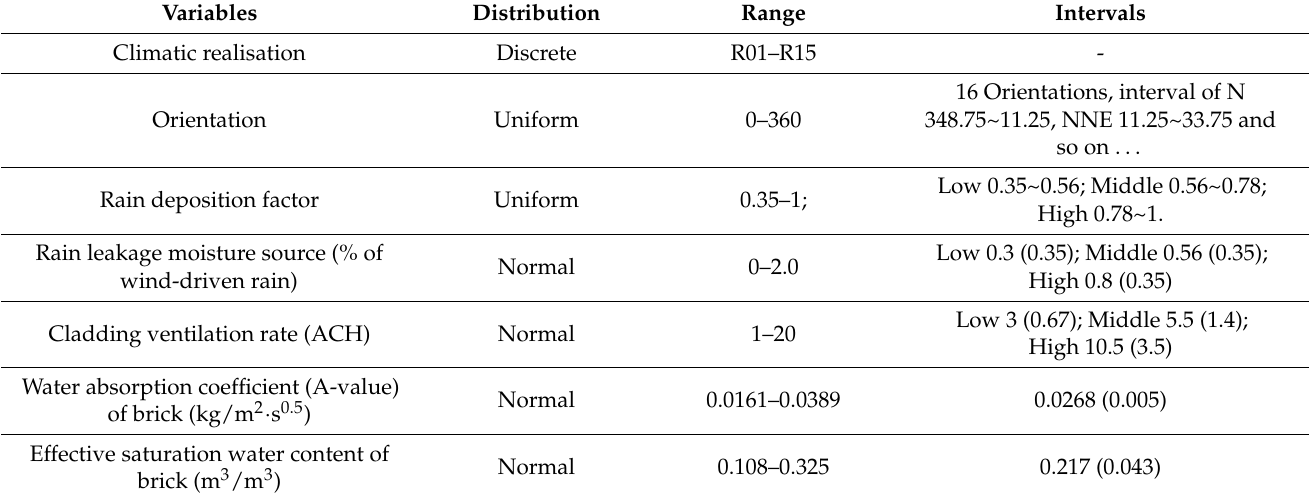
Table 9. Stochastic